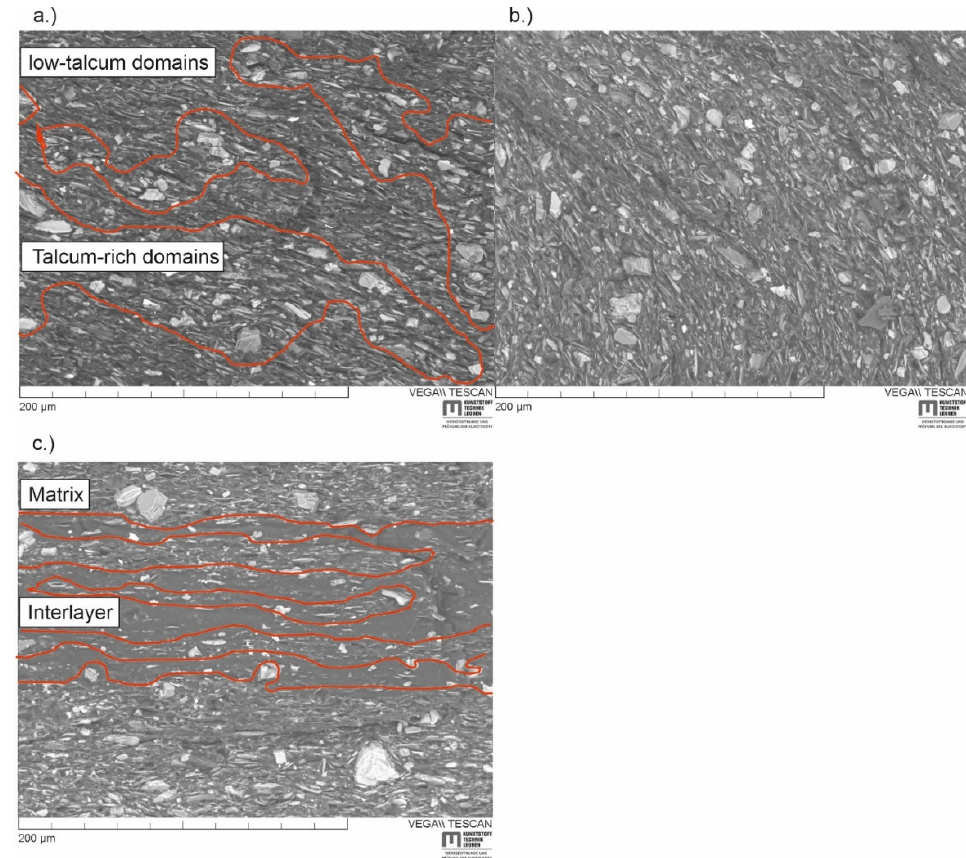
Figure 6. ( a ) SEM-micrographs of a cryofractured Blend and ( b ) Blend_512_L without defined layer structure and ( c ) a cryofractured ML_512L with distinct layers. Talcum-rich domains are separated from low-talcum domains by red lines.